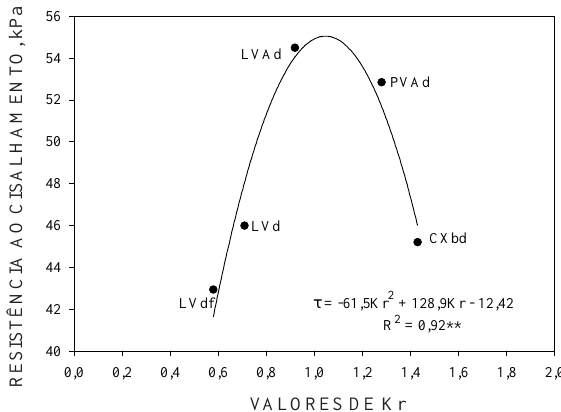
Figura 9. Variação da resistência ao cisalhamento dos solos com o índice